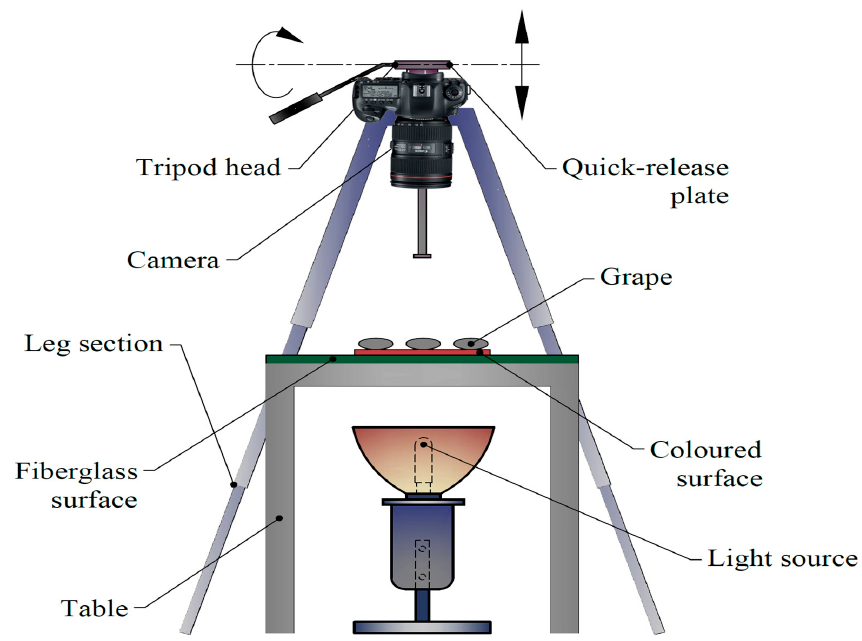
Figure 1. Vitis vinifera varieties.